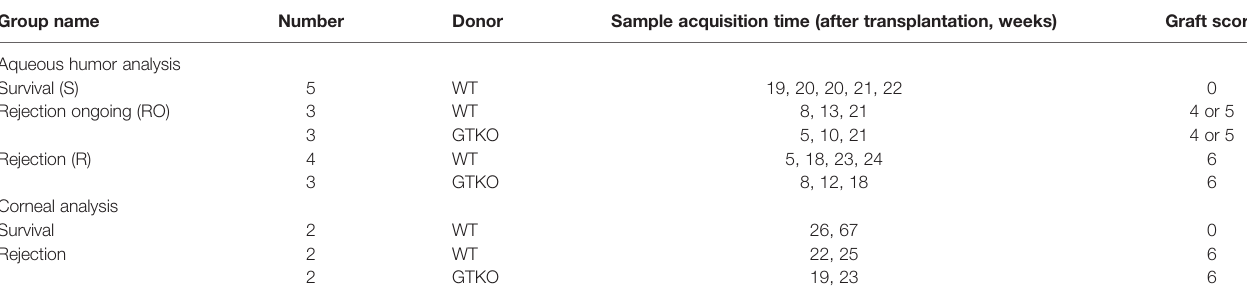
TABLE 1 | Summary of the groups used for corneal and aqueous proteomic analyses.